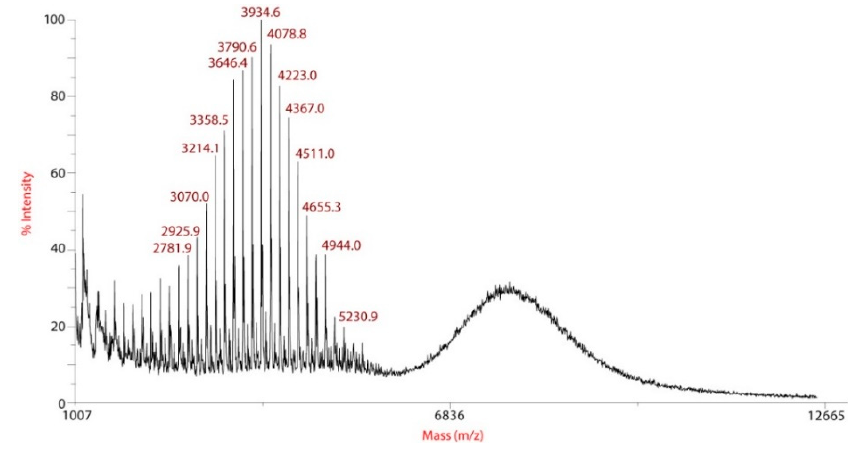
Figure 6. MALDI-TOF mass spectrum of purified product of step 3 (m/z 1007 to 12,665).